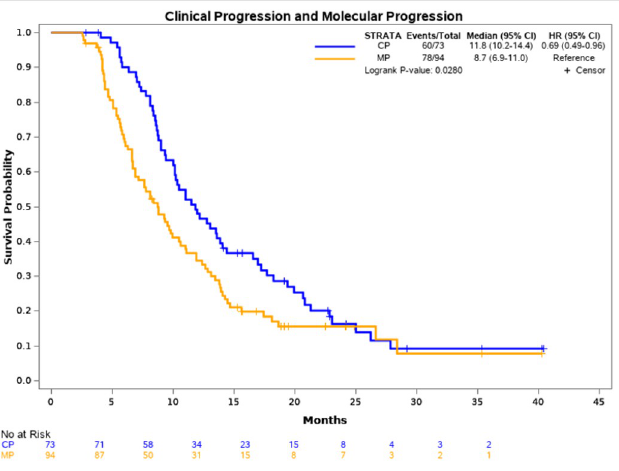
Fig 5. Kaplan-Meier survival analysis of patients with clinical progression versus patients with molecular progression. The median PFS of patients with molecular progression was 8.7 months vs 11.8 months for patients who clinically progressed. The HR was 0.69 with a p value of 0.0280.